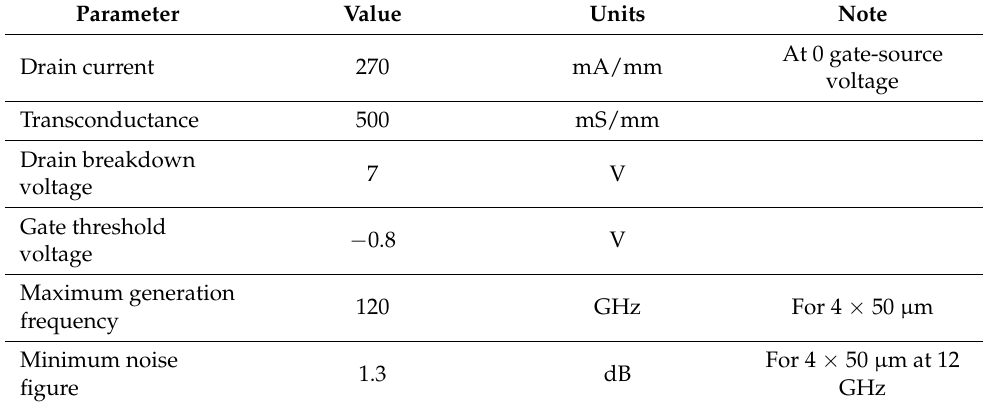
Table 1. The main transistor